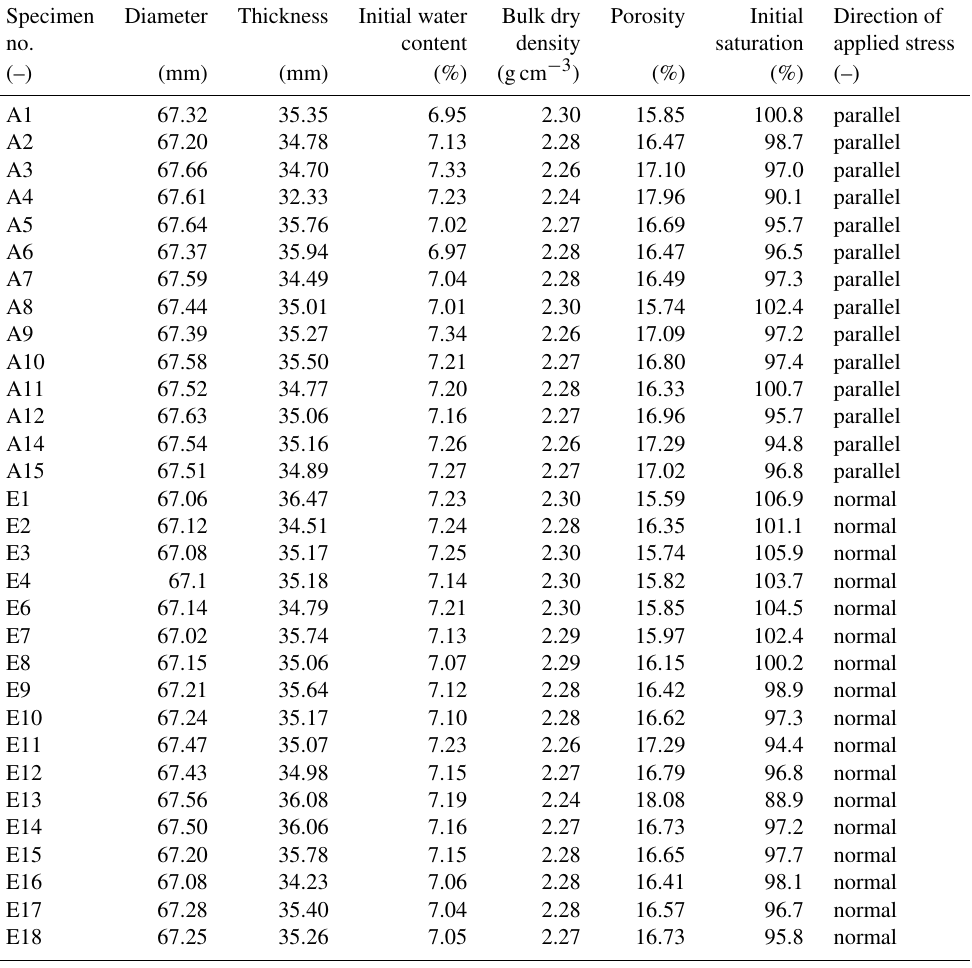
Table 1. Properties and test configurations of specimens. Water content, dry density, porosity, and initial saturation were determined according to ISRM (1979). Furthermore, the direction of the applied load with respect to bedding during the Brazilian tensile strength tests is indicated. Specimen